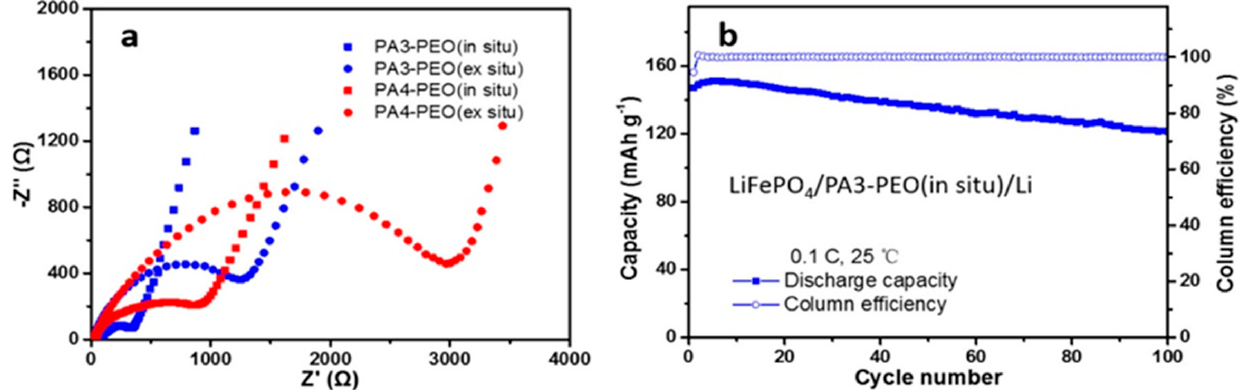
Figure 6. ( a ) Electrochemical impedance spectroscopy of CSPEs; ( b ) Cycling performance of LiFePO4/PA3-PEO/Li cells at 25 °C. Reprinted/adapted with permission from Ref. [97]. Copyright ® 2022, American Chemical Society.